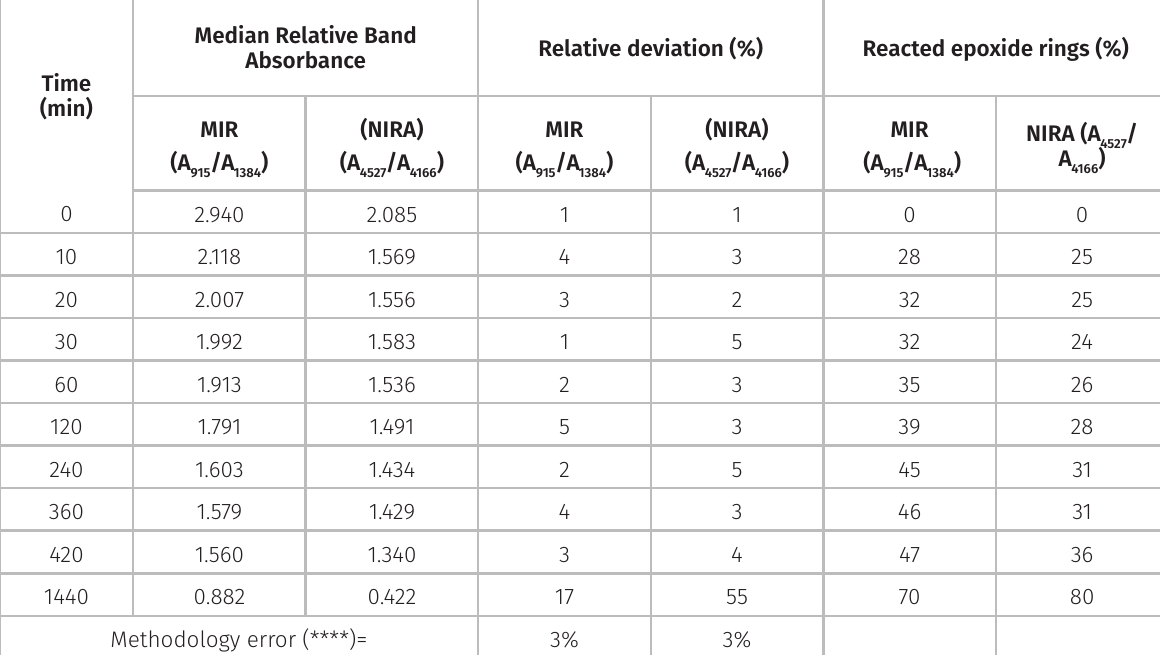
Table V. MIR and NIRA absorbances, errors and estimated percentage (%) of reaction of the epoxide rings for